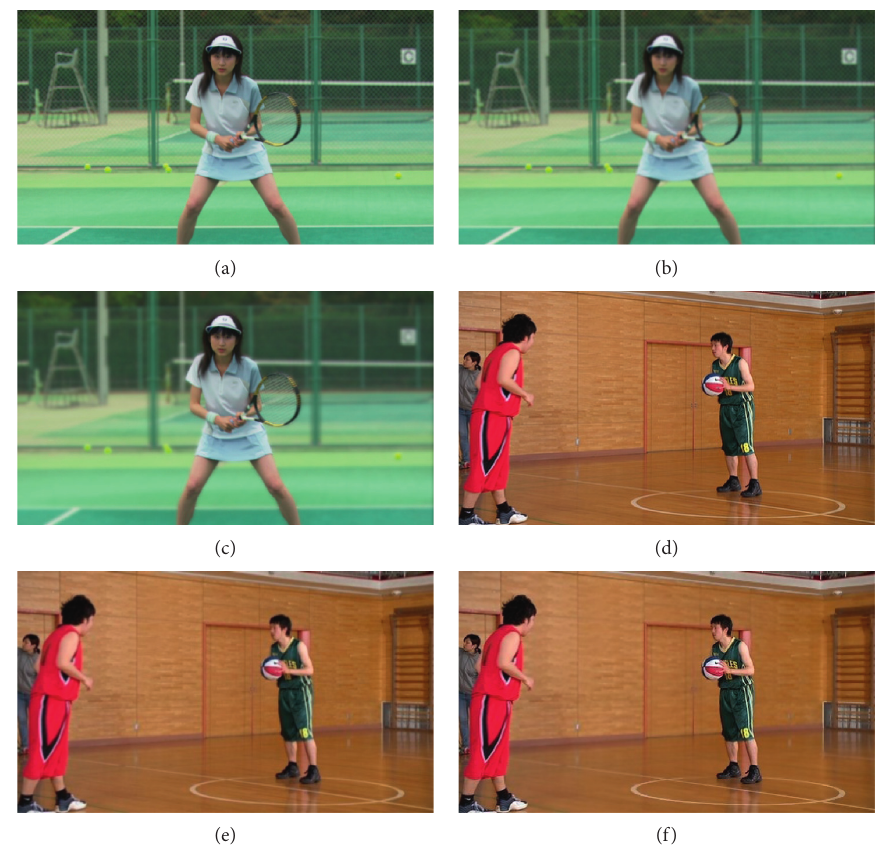
Figure 5: The experimental results between the K0103 algorithm and the ORC